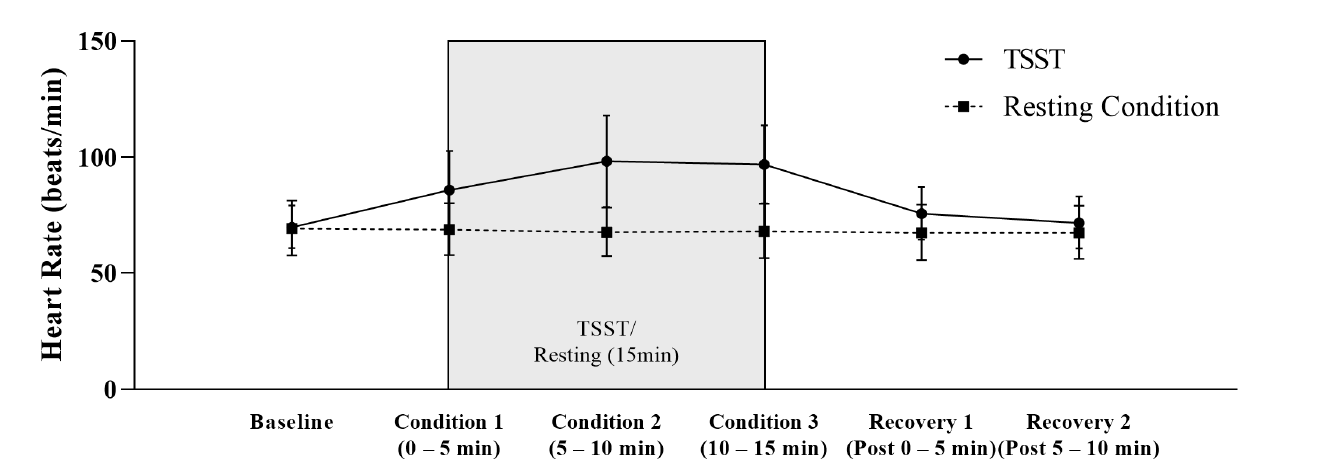
Figure 4. Heart Rate (M + SD) during Trier Social Stress Test and resting condition in healthy men ( n = 23). Table 3. Pearson’s correlations (r) between psychological, cfDNA, and cortisol measures.